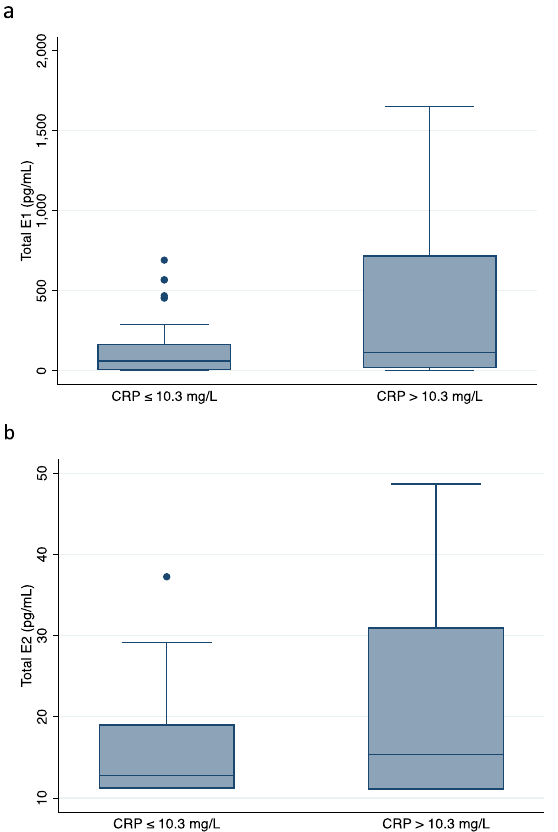
Fig. 5 Box graphs of serum estrogen levels by CRP status (HER2 − subjects). a Detectable E1 levels strati fi ed by high CRP status; b Detectable E2 levels strati fi ed by high CRP status. Description: Whisker endpoints represent the range of results (minimum- maximum), box limits represent the interquartile range (between the upper and lower quartiles), center line represents the